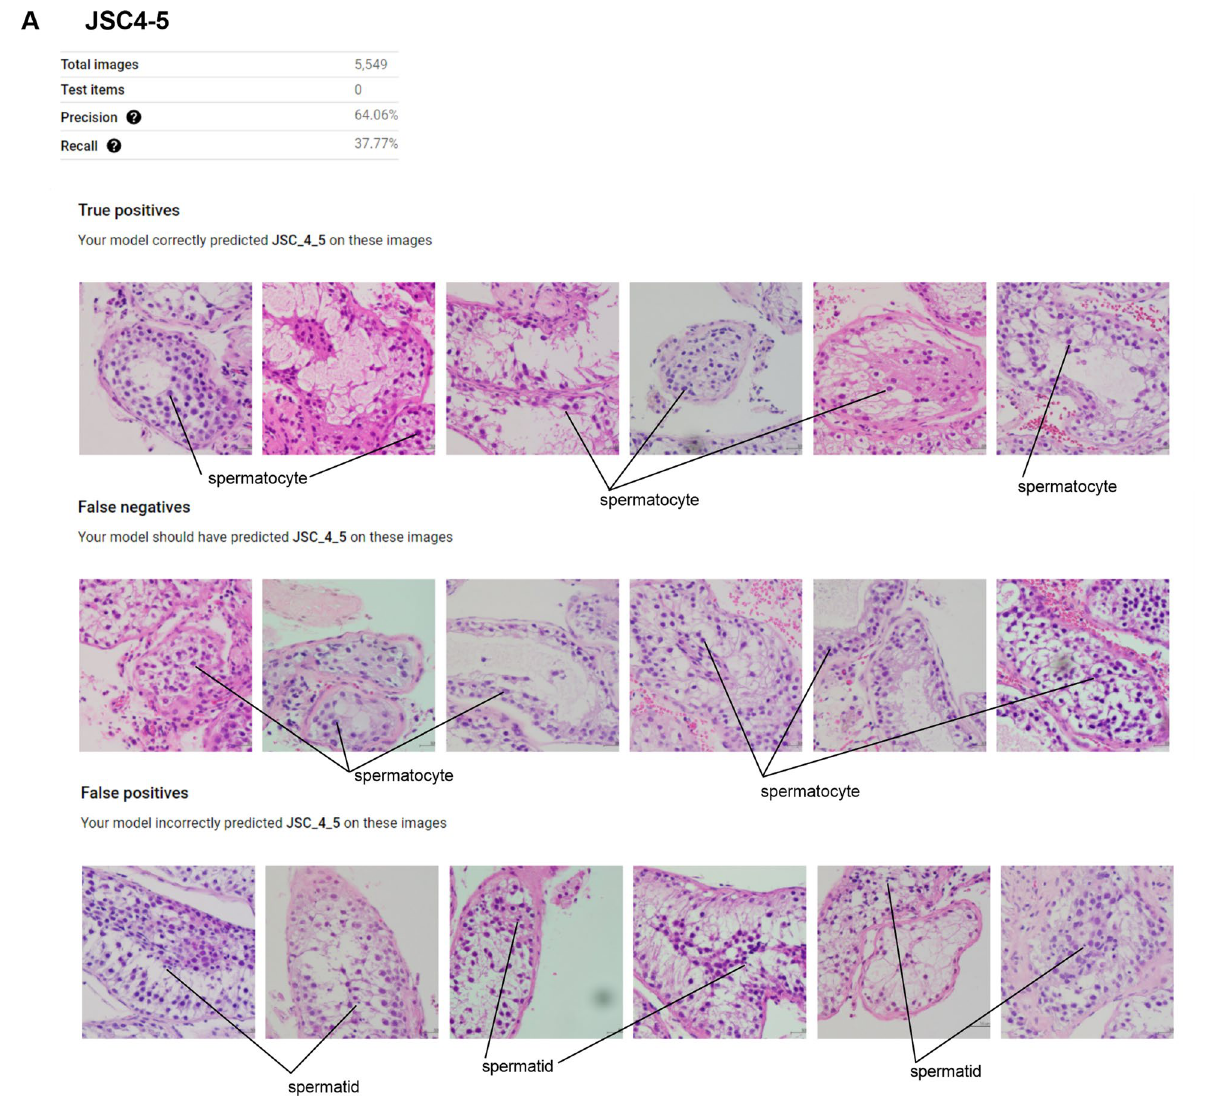
Figure 3. Features of true positives, false negatives, and false positives for